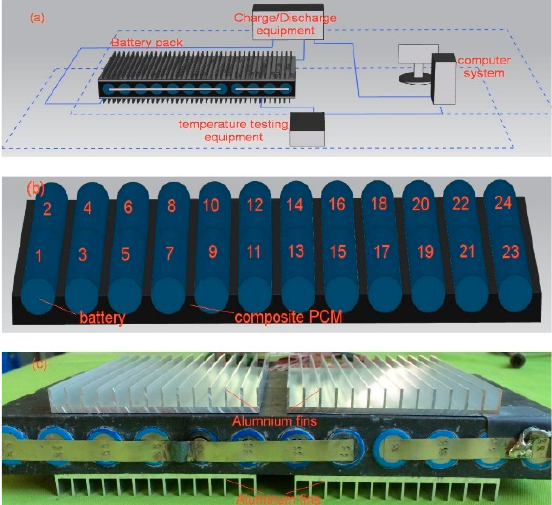
Figure 13. The experimental set up discussed in [55]: ( a ) functional diagram; ( b ) cross-section of the battery pack showing the 24 cells (numbered from 1 to 24); ( c ) battery pack coupling with the heat dissipation fins. Reproduced with permission from Elsevier.